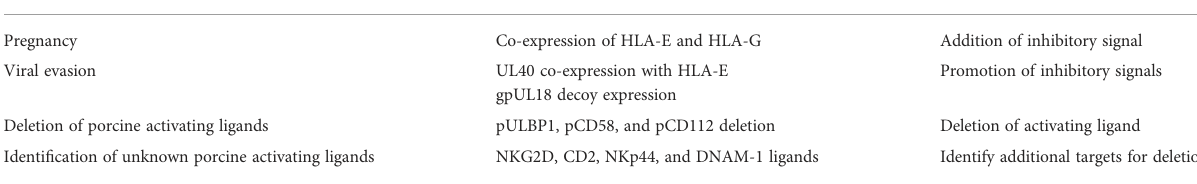
TABLE 1 Proposed Directions to Reduce NK Cell-Mediated